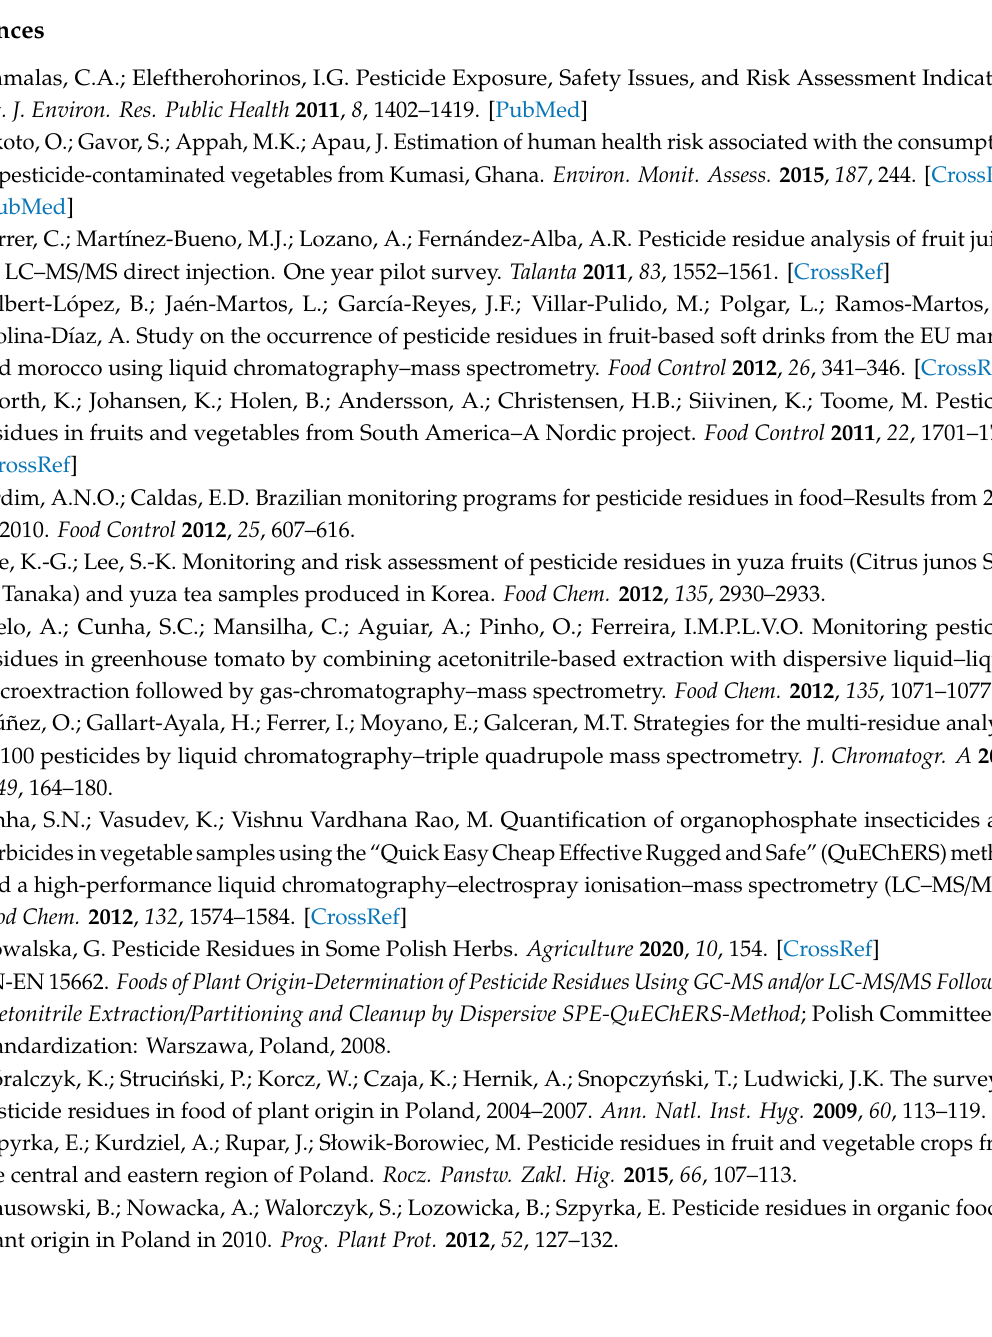
Table S1: List of pesticides determined in the positive ionization mode, Table S2: List of pesticides determined in the negative ionization